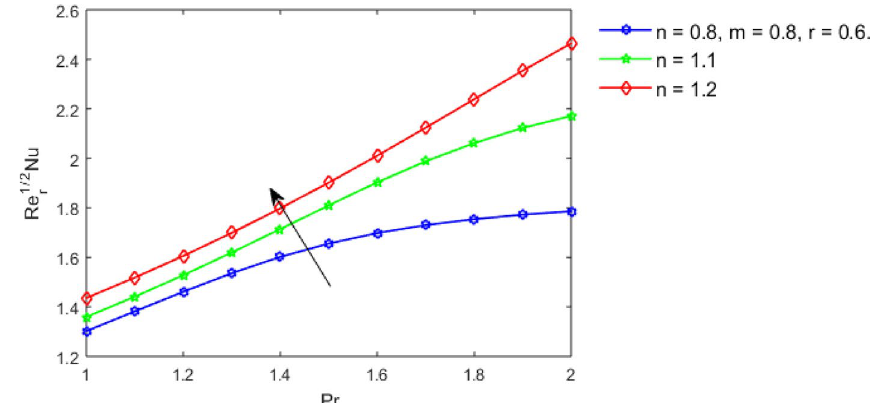
Figure 21. Heat transfer rate by the power-law index n for increasing Pr .